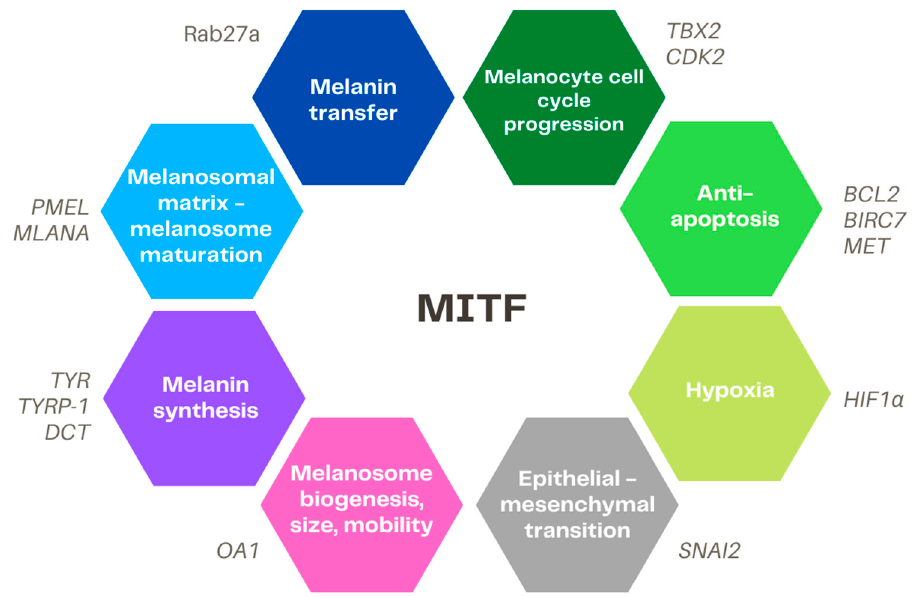
Figure 2. Overview of the main targets of MITF. MITF = microphthalmia-associated transcription factor, PMEL = premelanosome protein, MLANA = Melan-A, Rab27a = RAB27A, member RAS onco- gene family, TBX2 = T-box transcription factor 2, CDK2 = cyclin dependent kinase 2, BCL2 = BCL2 apoptosis regulator, BIRC7 = baculoviral IAP repeat containing 7, MET = MET proto-oncogene, receptor tyrosine kinase, HIF1 α = hypoxia-inducible factor 1 alpha, SNAI2 = snail family transcrip- tional repressor 2, OA1 = ocular albinism 1, TYR = tyrosinase, DCT = dopachrome tautomerase, TYRP-1 = tyrosinase-related protein 1.